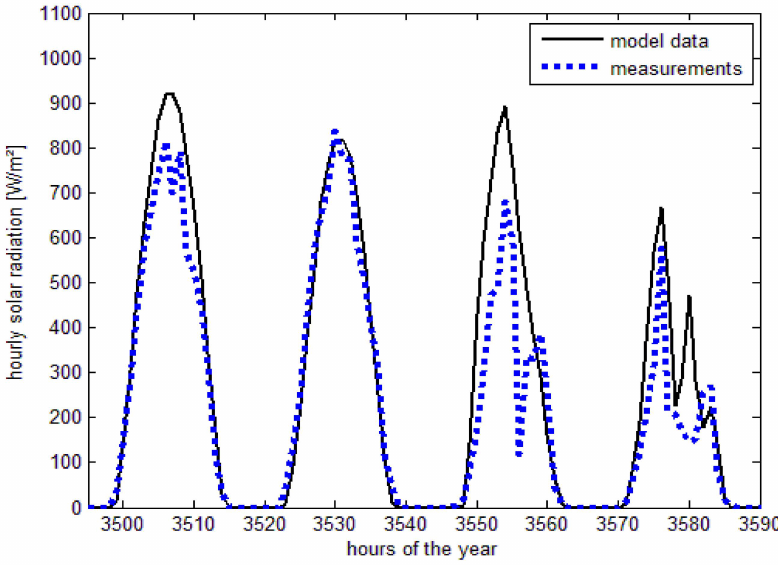
Figure 6. Illustrative excerpt from the irradiation time series (station: